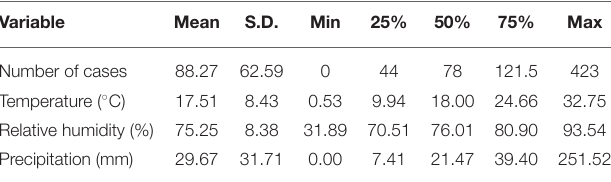
TABLE 1 | Weekly summary of hand-foot-mouth disease (HFMD) cases and meteorological factors in Zhejiang province, China, 2010–2018.